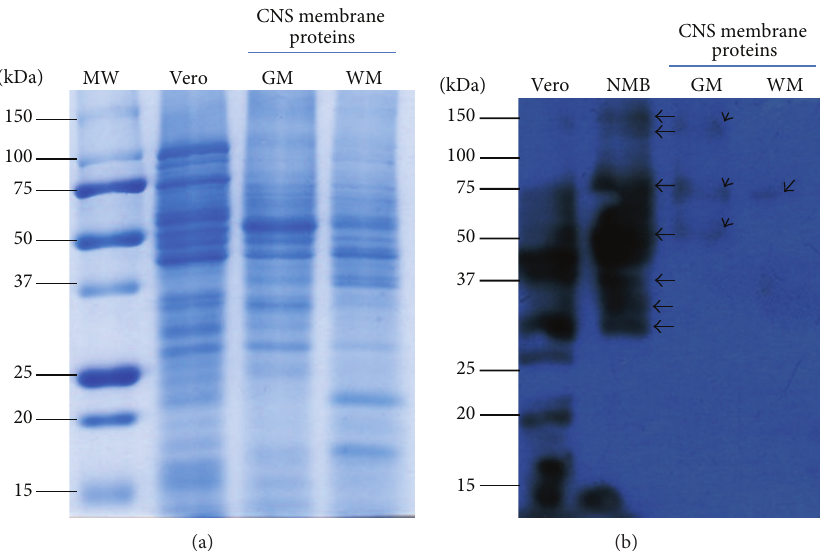
Figure 1: Binding of dengue virus type 2 (DENV-2) to membrane proteins of the central nervous system (CNS). To establish which proteins in the human CNS were involved in binding DENV, VOPBA were carried out by using the entire DENV particles precipitated with polyethylene glycol and membrane proteins obtained from either white or gray matter from human tissue. Three membrane proteins (60, 70, and 130 kDa) from gray matter were found to bind the entire viral particle, while only one of them (70 kDa) was so identified in the white matter. MW: molecular weight; Vero: membrane proteins from Vero cells; NMB: membrane proteins form neonatal mouse brain; GM: membrane proteins from gray matter; WM: membrane proteins from white matter; kDa: kilodaltons. Arrows point to the proteins detected to bind virus